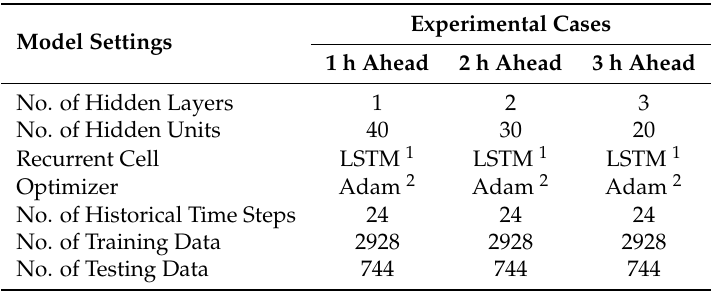
Table 3. Experiments